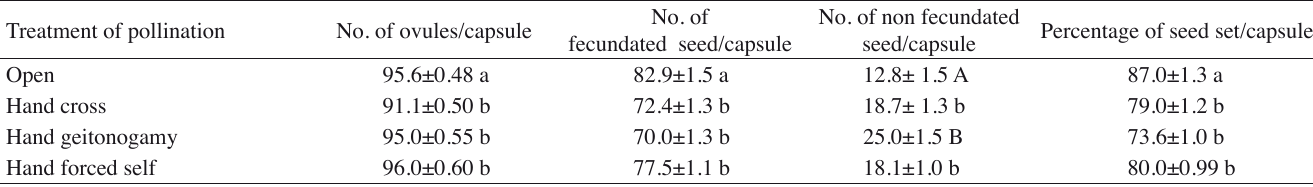
Table 2 - Seeds set after different pollination treatment in Nigella sativa location B. Season one Treatment of pollination No. of ovules/capsule